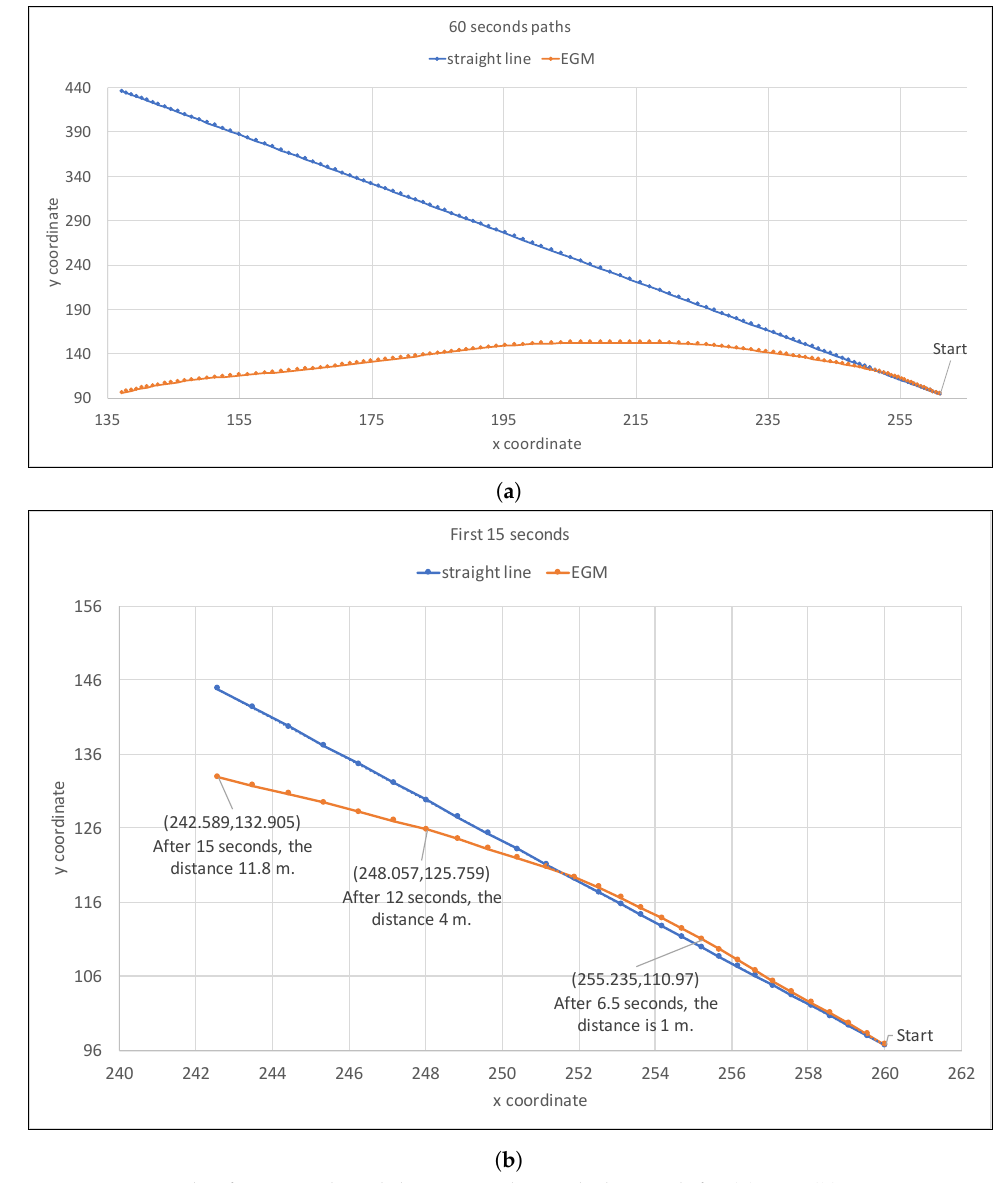
Figure 13. Sample of EGM path and the expected straight line path for ( a ) 60 s; ( b ) 15 s. Table 3. Average false alarms with different airspace